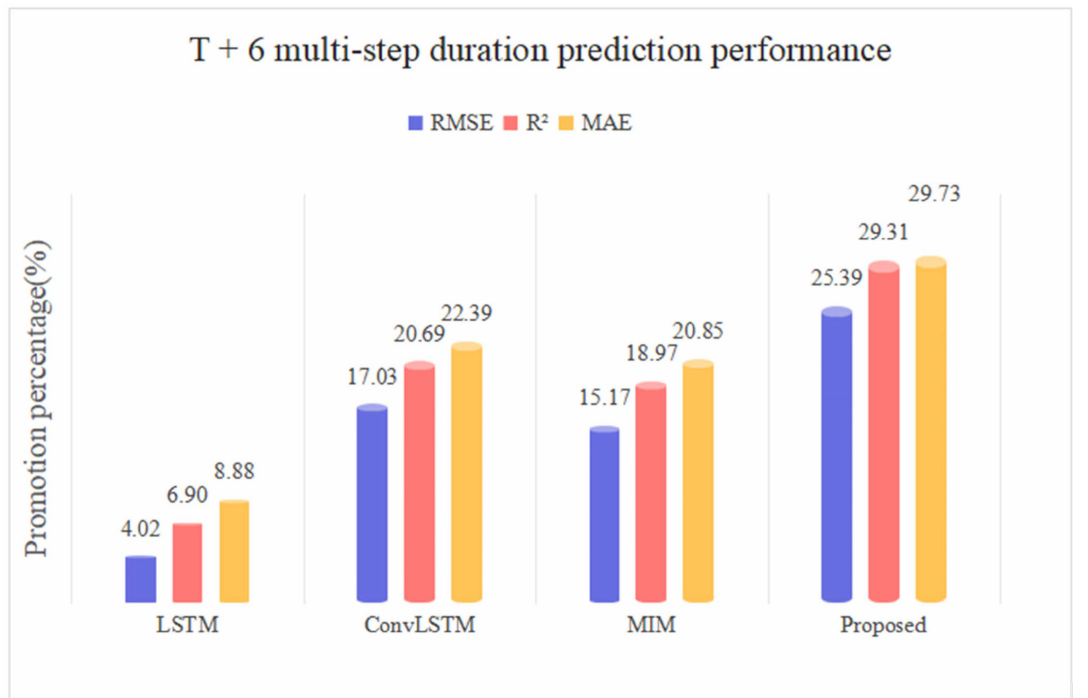
Figure 12. T + 6 multi-step duration prediction